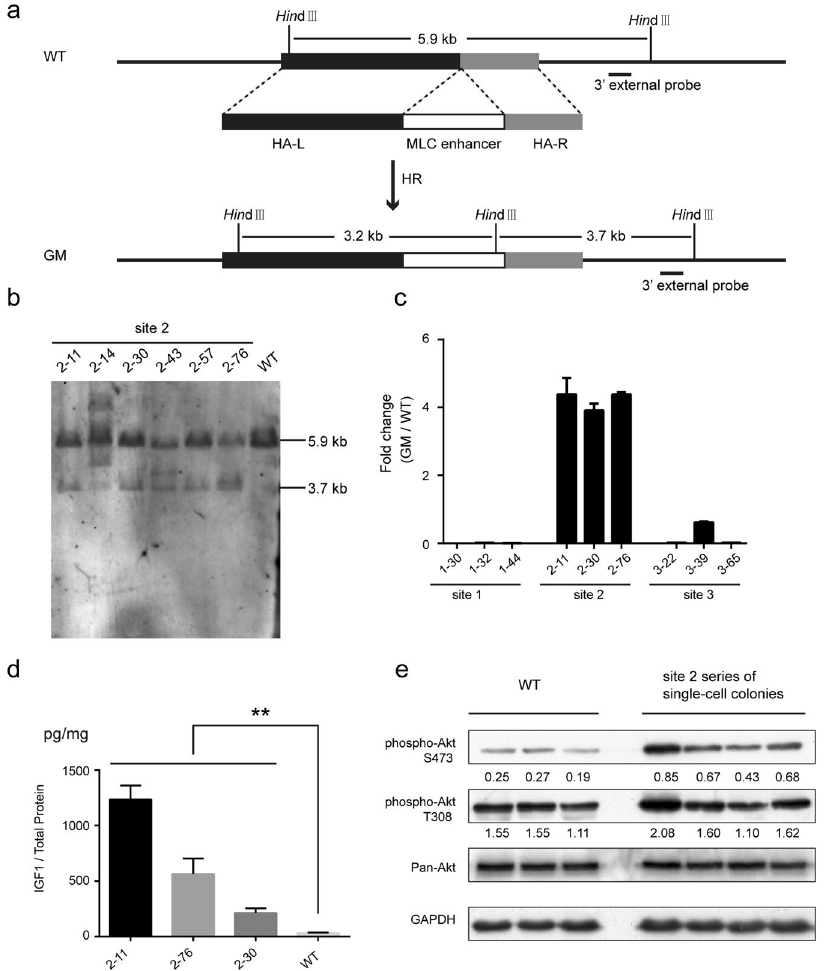
Figure 3. Evaluation of the ability of the candidate sites to support IGF1 expression in C2C12 single-cell colonies. (a) Schematic of the strategy used to knock in the MLC enhancer by homologous recombination (HR). The site 2 is chosen as an example; the strategy was the same for the site 1 and site 3. The black and grey blocks represent the 5 ′ long homology arm (HA-L) and 3 ′ short homology arms (HA-R), respectively. The white blocks represent the incorporated MLC enhancer. The restriction enzyme used for Southern blot analysis is shown. The 3 ′ external probe is shown as a short black line. (b) Southern blot analysis of the incorporated MLC enhancer in the site 2. Genomic DNA of the site 2 series of single-cell colonies and the WT control was digested with Hin dIII and then hybridized with the 3 ′ external probe. The expected fragment sizes are: WT, 5.9 kb; GM, 3.7 kb. (c) Real-time quantitative PCR analysis of the relative expression levels of Igf1 mRNA in myotubes of the site 1, site 2, site 3 series of single-cell colonies. The results were displayed as fold changes relative to the expression levels in WT C2C12 myotubes using the 2 − △△ CT method. Values are mean ± SEM of three independent experiments. (d) ELISA analysis of the IGF1 protein levels in myotubes of the site 2 series of single-cell colonies and the WT control. The total IGF1 levels are normalized to the total protein levels. Values are mean ± SEM of three independent experiments. (e ) Western blot analysis of the Akt phosphorylation levels in myotubes of the site 2 series of single-cell-colonies and the WT control. Antibodies against phosphorylated Akt (Ser473), Akt (Thr308), and total Akt were used. GAPDH was used as a loading control. The ratio of the phosphorylated Akt (Ser473)/Pan-Akt and the phosphorylated Akt (Thr308)/Pan-Akt were determined by calculating the blot intensities and are shown below each respective blot. All gels/blots were run under the same experimental conditions. Shown are cropped gels/blots (Full-length gels/blots with indicated cropping lines are shown in Supplementary Figure